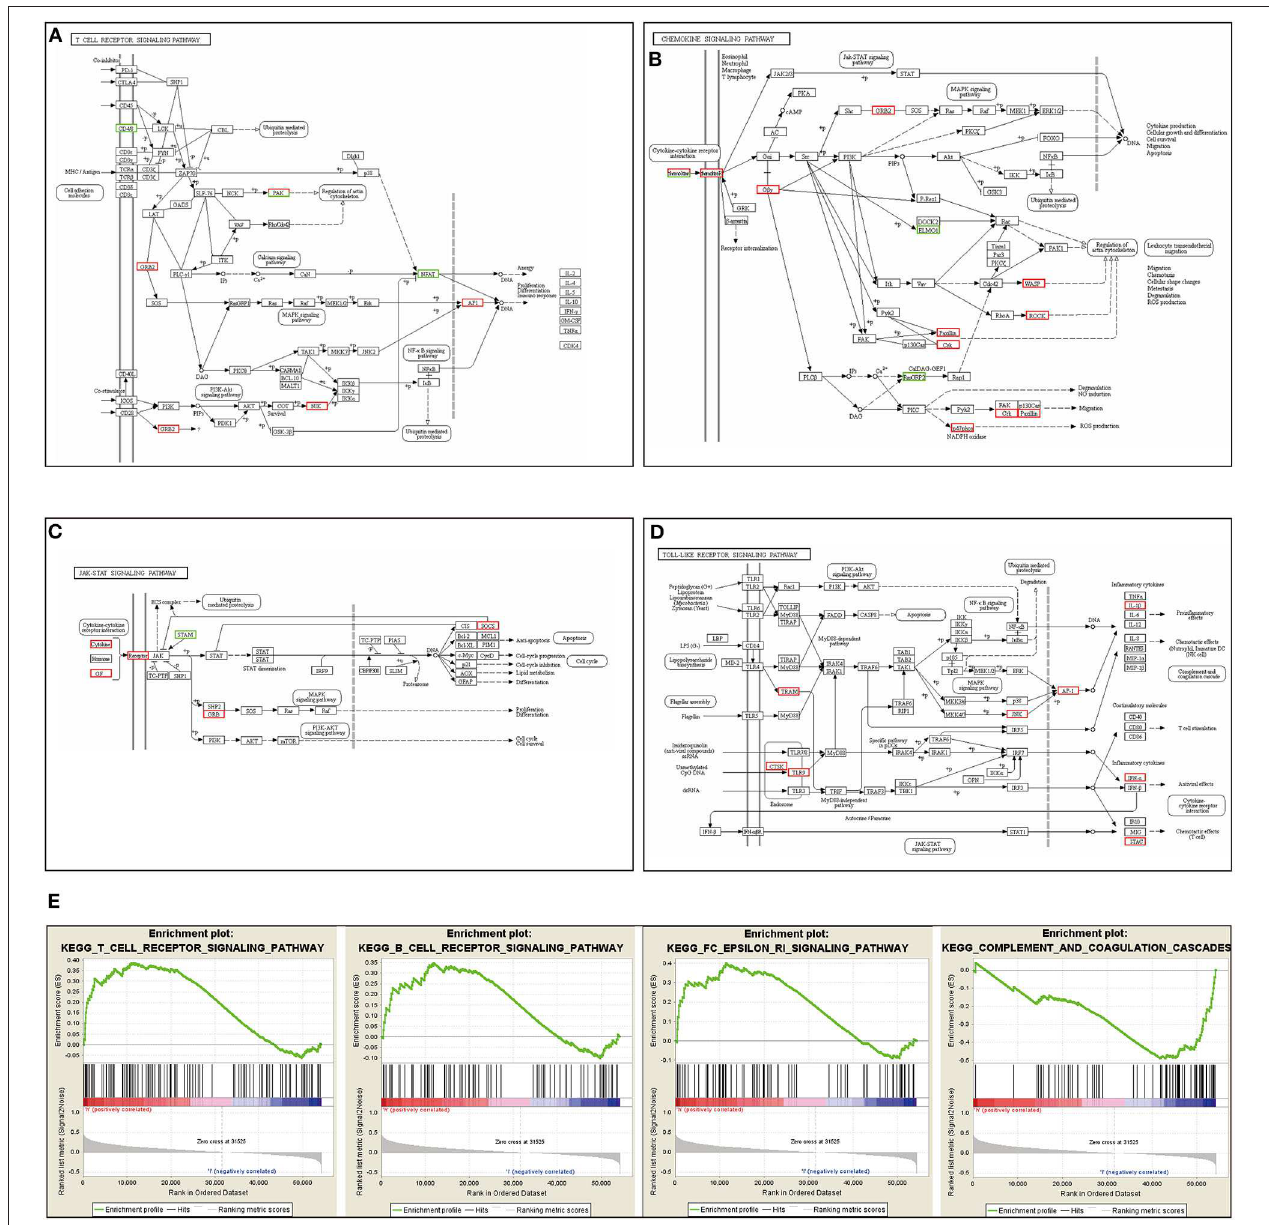
FIGURE 4 | Immune signaling pathways related to ACK1/TNK2. (A–D) RNA-seq analysis after the silencing of the ACK1 / TNK2 gene of A549 cells. Differentially expressed genes were involved in the T cell receptor signaling pathway, chemokine signaling pathway, JAK-STAT signaling pathway, and Toll-like signaling pathways. (E) Dissection of ACK1-associated immune signaling pathways by Gene Set Enrichment Analysis of 188 lung cancer cell lines from the Cancer Cell Line Encyclopedia database.